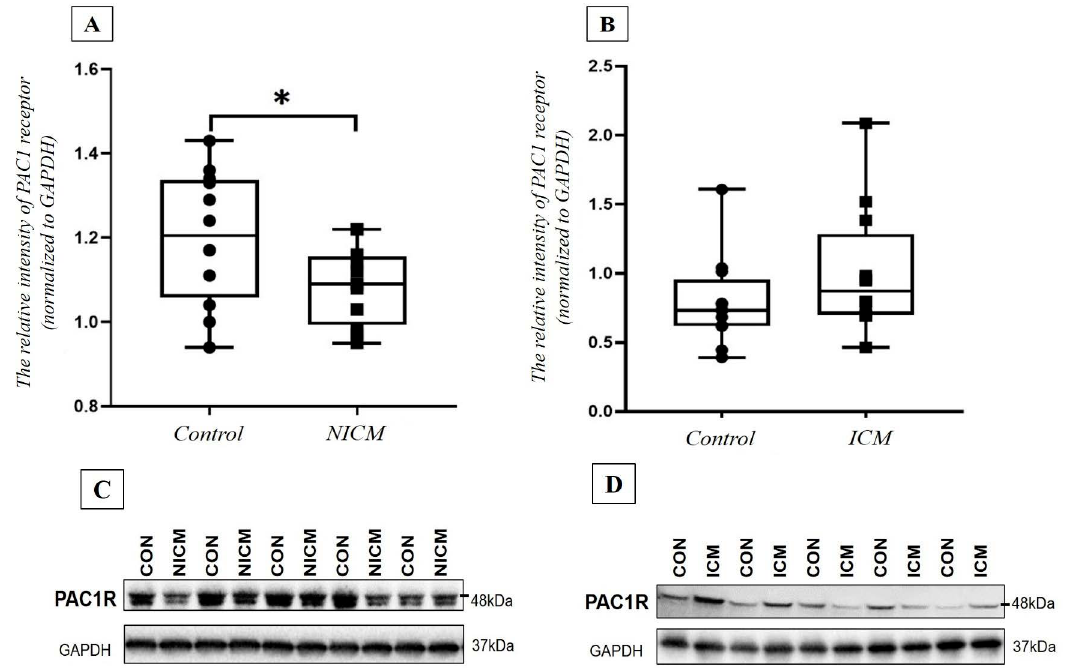
Figure 7. PAC1 receptor relative intensity in non-ischemic cardiomyopathy ( A ) (NICM, n = 11) and ischemic cardiomyopathy ( B ) (NICM, n = 11; ICM, n = 12) vs. control group (CON, n = 12). ( C , D ) pictures show the scanned Western blot representative images. PAC1 receptor values are normalized to GAPDH. The box plot diagram represents the interquartile range and median values. The individual values are presented with black dots (control group) or squares (NICM or